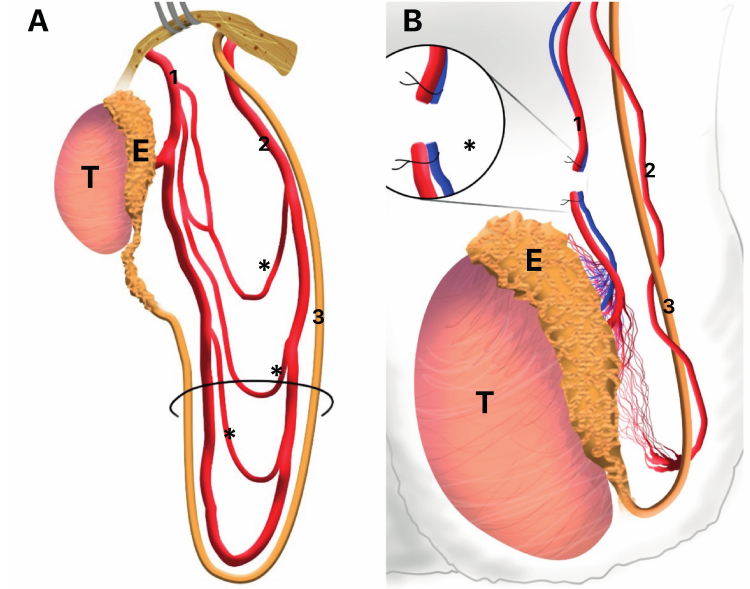
Figure 6 - Testicular arteries pattern showed in the original Fowler-Stephens paper (x). A) Schematic drawing showing the vascular supply of the testis, we can observe an important collateral circulation (*) through the Testicular artery (1) and deferential artery (2), 3- Vas deferens; B) Schematic drawing showing the place of ligature of testicular vessels (*) in Fowler- Stephens surgery, T- testis, E-